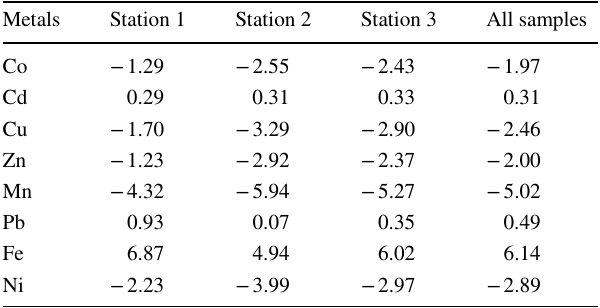
Table 3 Geoaccumulation index values for sediment samples from the Benin River